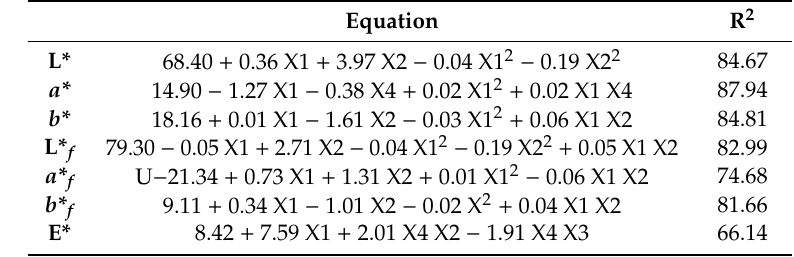
Table 2. Adjusted statistical models of the colorimetric behavior of polydiacetylene (PDA) films as a function of the coordinates L*, a* , b* and the calculated factor ∆ E*.